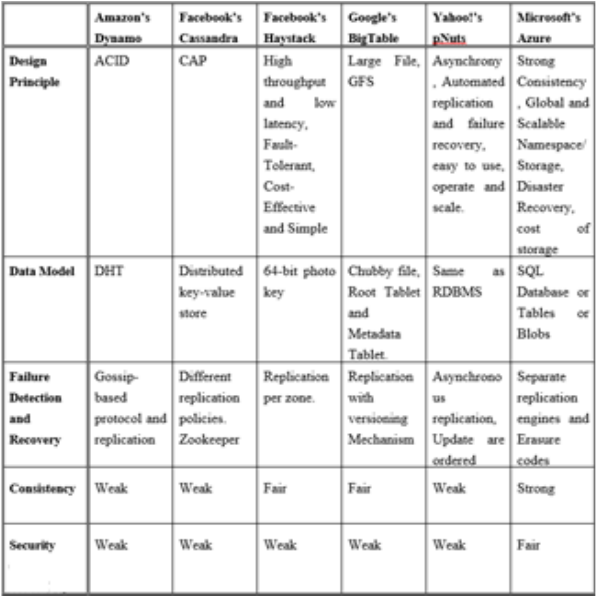
Table 2. Summary of features of DSSs